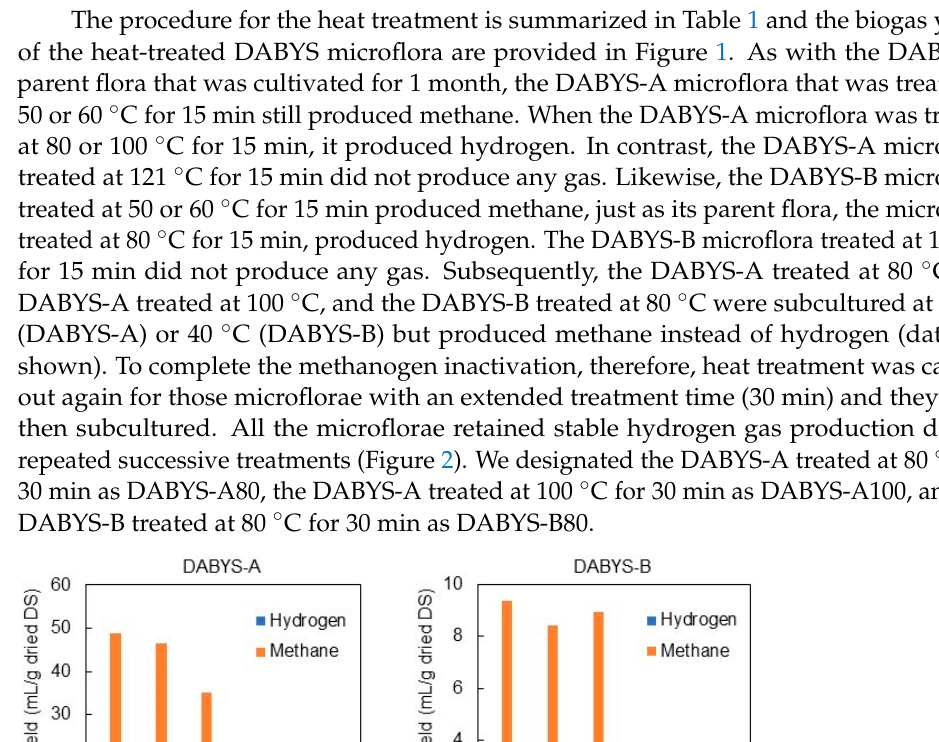
Table 1. Summary of the heat-treatment procedure and gas production by the treated florae in the dark fermentation.